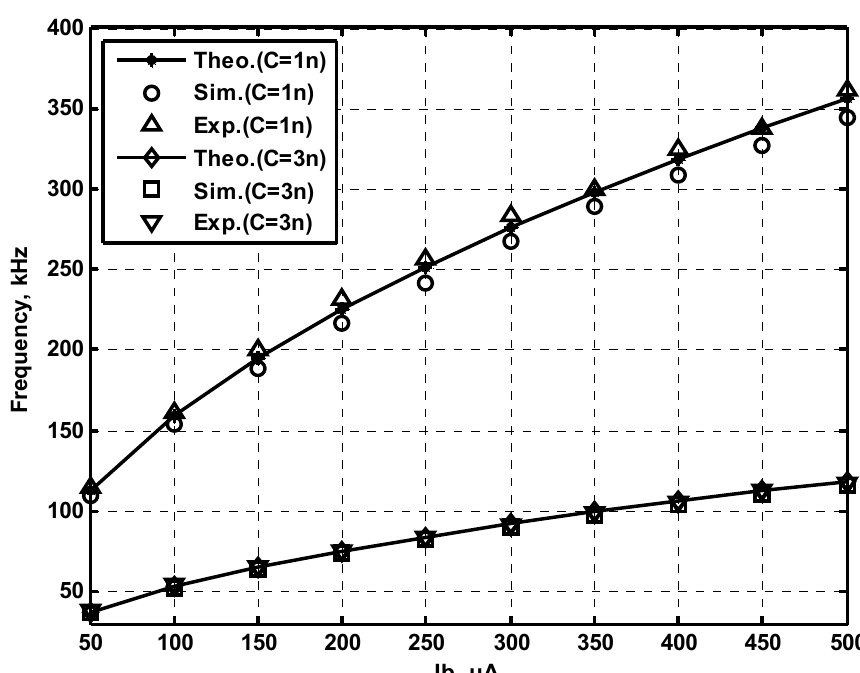
Figure 26. The measured frequency spectrum of the V o2 output terminal. Electronics 2020 , 9 , x FOR PEER REVIEW